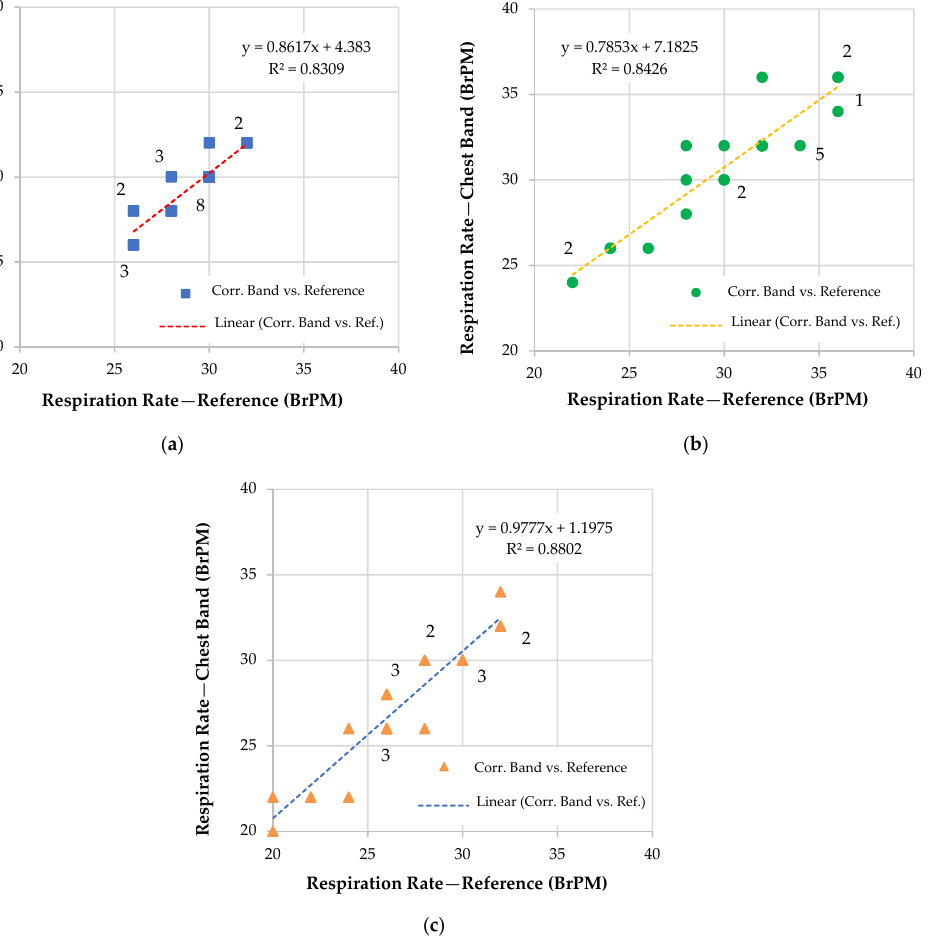
Figure 10. Correlation diagrams between measurements obtained from the chest band and the reference ones obtained with the spirometer for three operative scenarios, namely, for a user: seated ( a ), standing ( b ), and walking at 1 ms − 1 ( c ). The data point’s multiplicity is reported in the graphs. Additionally, Figure 11 shows the Bland–Altman plots related to the RR measure- ments acquired through the use of the inertia-based chest band and the reference ones for different operative conditions (i.e., seated, standing, and walking). These data represen- tations enables the evaluation of the accordance between the two considered measure- ment methods through two parameters, namely, the LoA and MD.